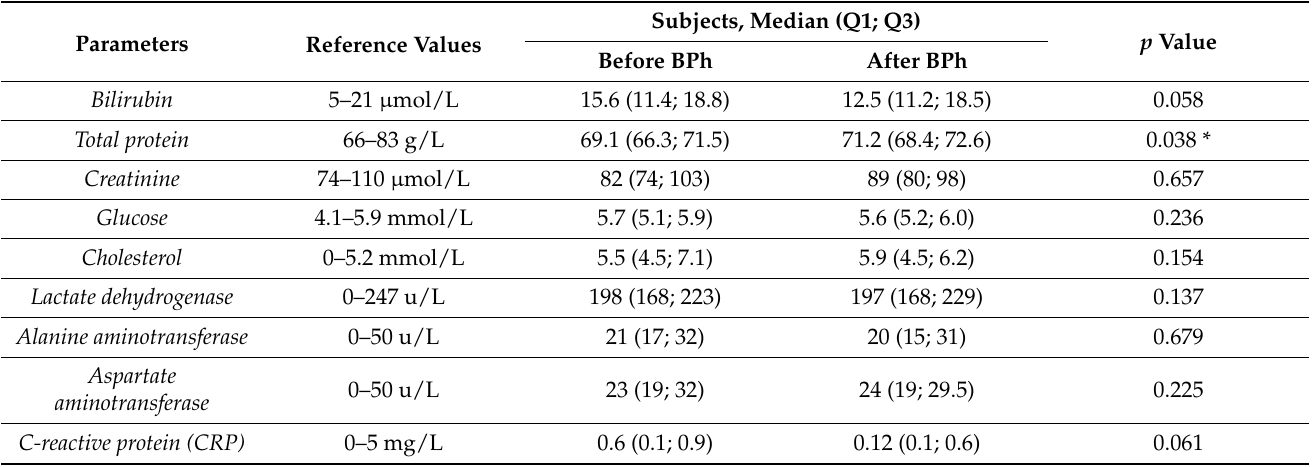
Table 2. Changes in the biochemical analysis of blood samples in subjects on the bacteriophage therapy (BPh). * Correlation is statistically